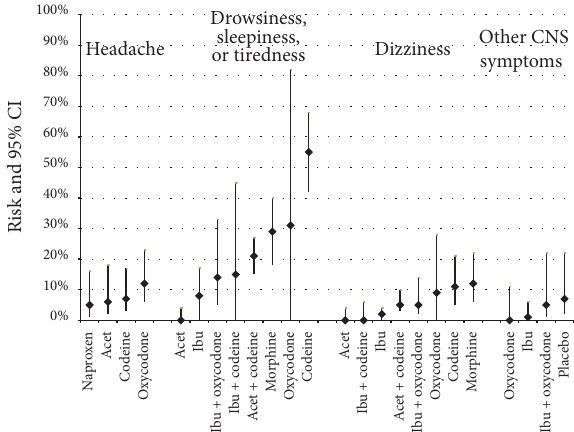
Figure 3: Risk (incidence rate) of headache, drowsiness, dizziness, and other minor central nervous system symptoms by medication. ∗ Other minor central nervous system (CNS) symptoms included being lightheaded, agitation, twitchiness, and unspecific CNS symp- toms. Results are presented in lowest to highest risk order with placebo at the end (where data were available).